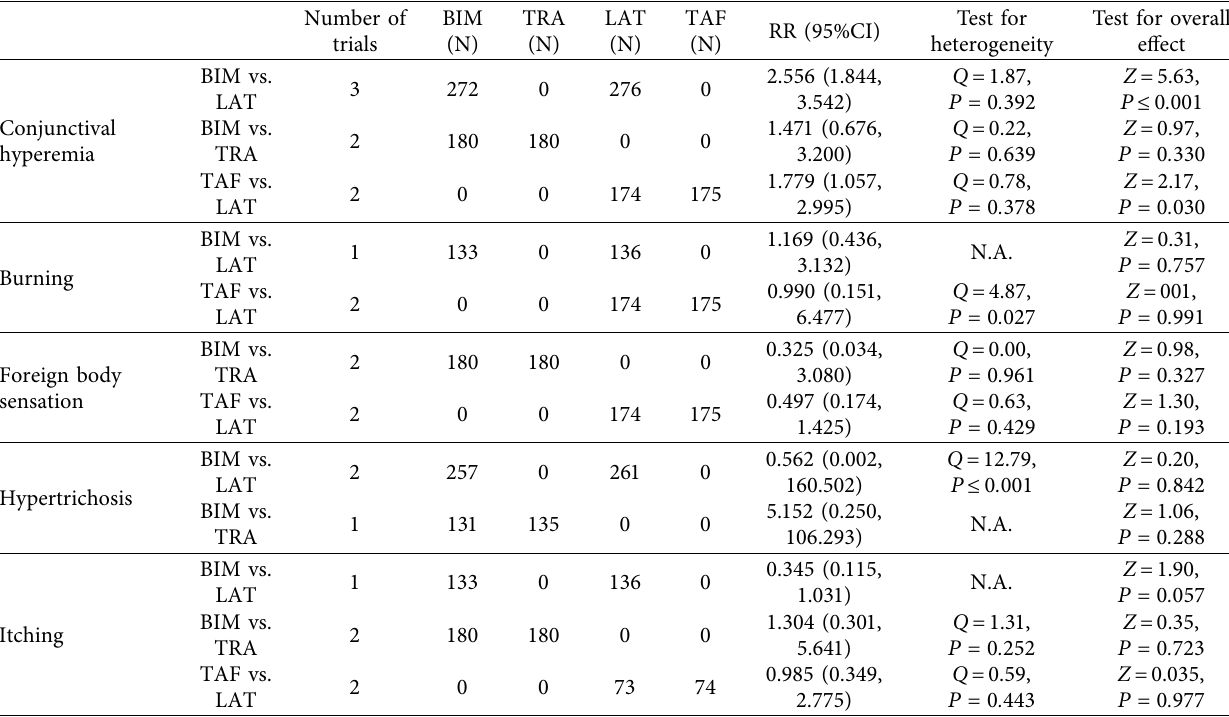
Table 9: Safety analysis for